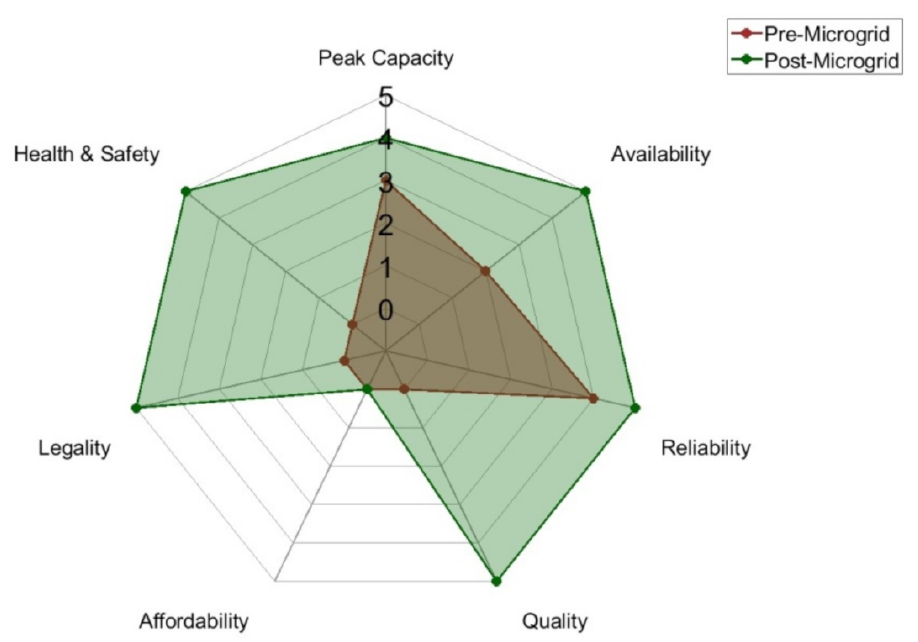
Figure 20. Spider plot of Gilutongan Island’s electricity access MTF tiers before and after the installation of the solar